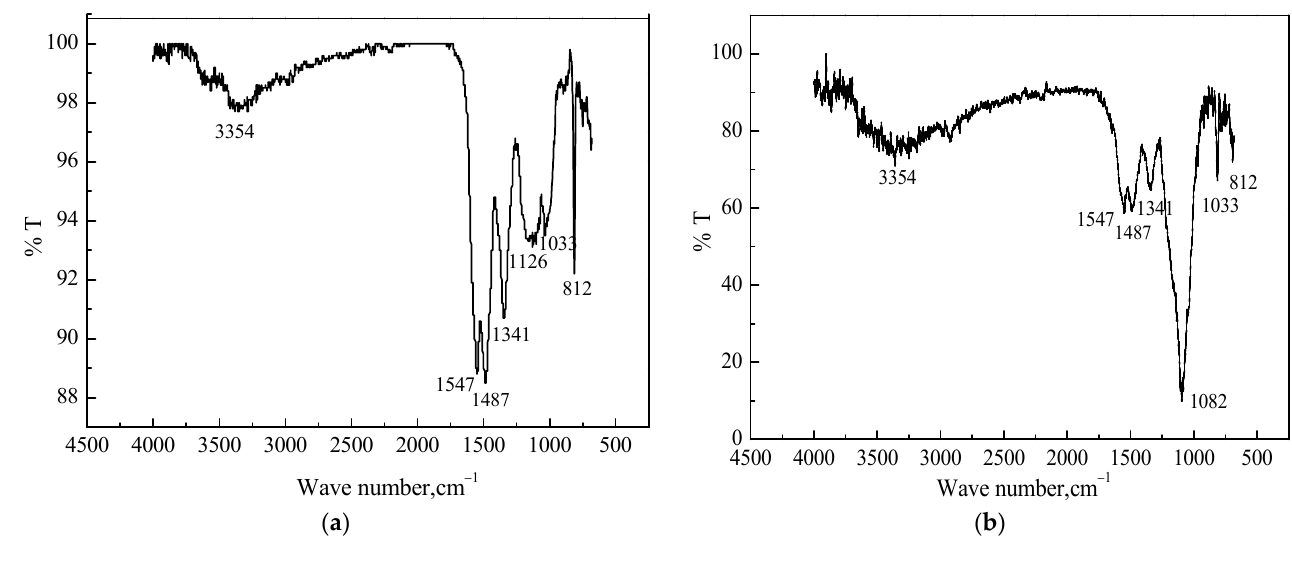
Figure 5. The FTIR spectra of ( a ) MS; ( b ) MS@PVC@SiO 2 . Table 1. Mechanical properties of the sponge